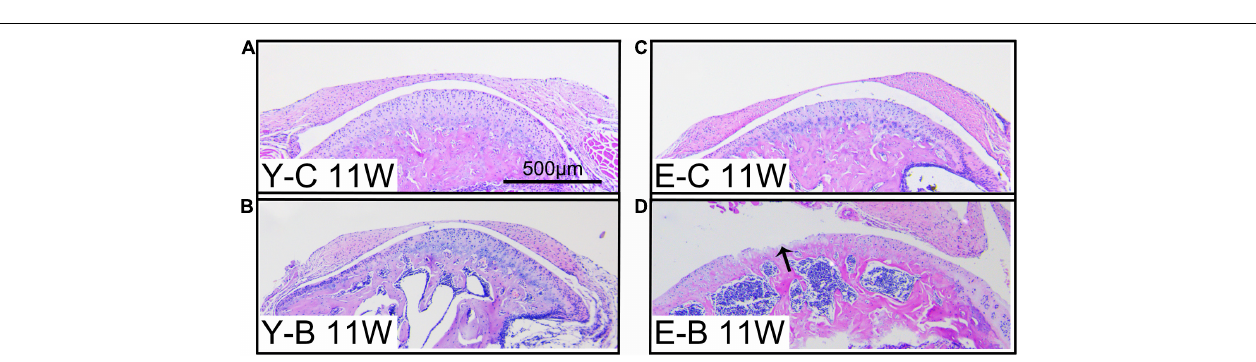
FIGURE 5 | Typical images of younger (Y-) and elder (E-) mice in the control (-C) and BAC (-B) groups at 11 weeks after the BAC operation, labeled as Y-C 11W (A) , Y-B 11W (B) , E-C 11W (C) , and E-B 11W (D) , respectively. Bars = 500 µ m.